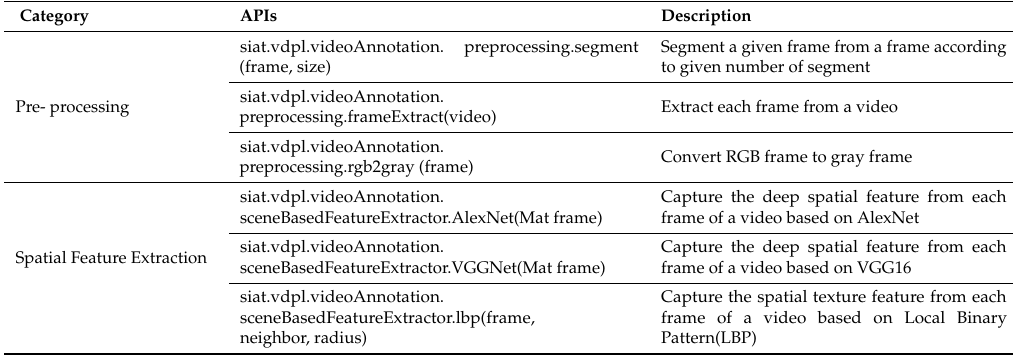
Table A1. Proposed video annotation